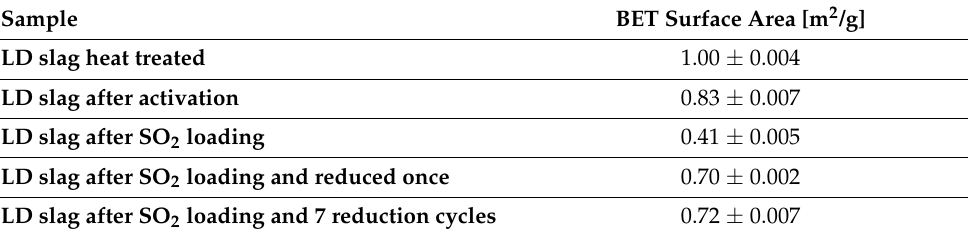
Table 7. BET surface area of LD slag particles before and after sulfur loading. It is clear that there is a drop in surface area after SO 2 loading and that the surface area is increased again after reduction